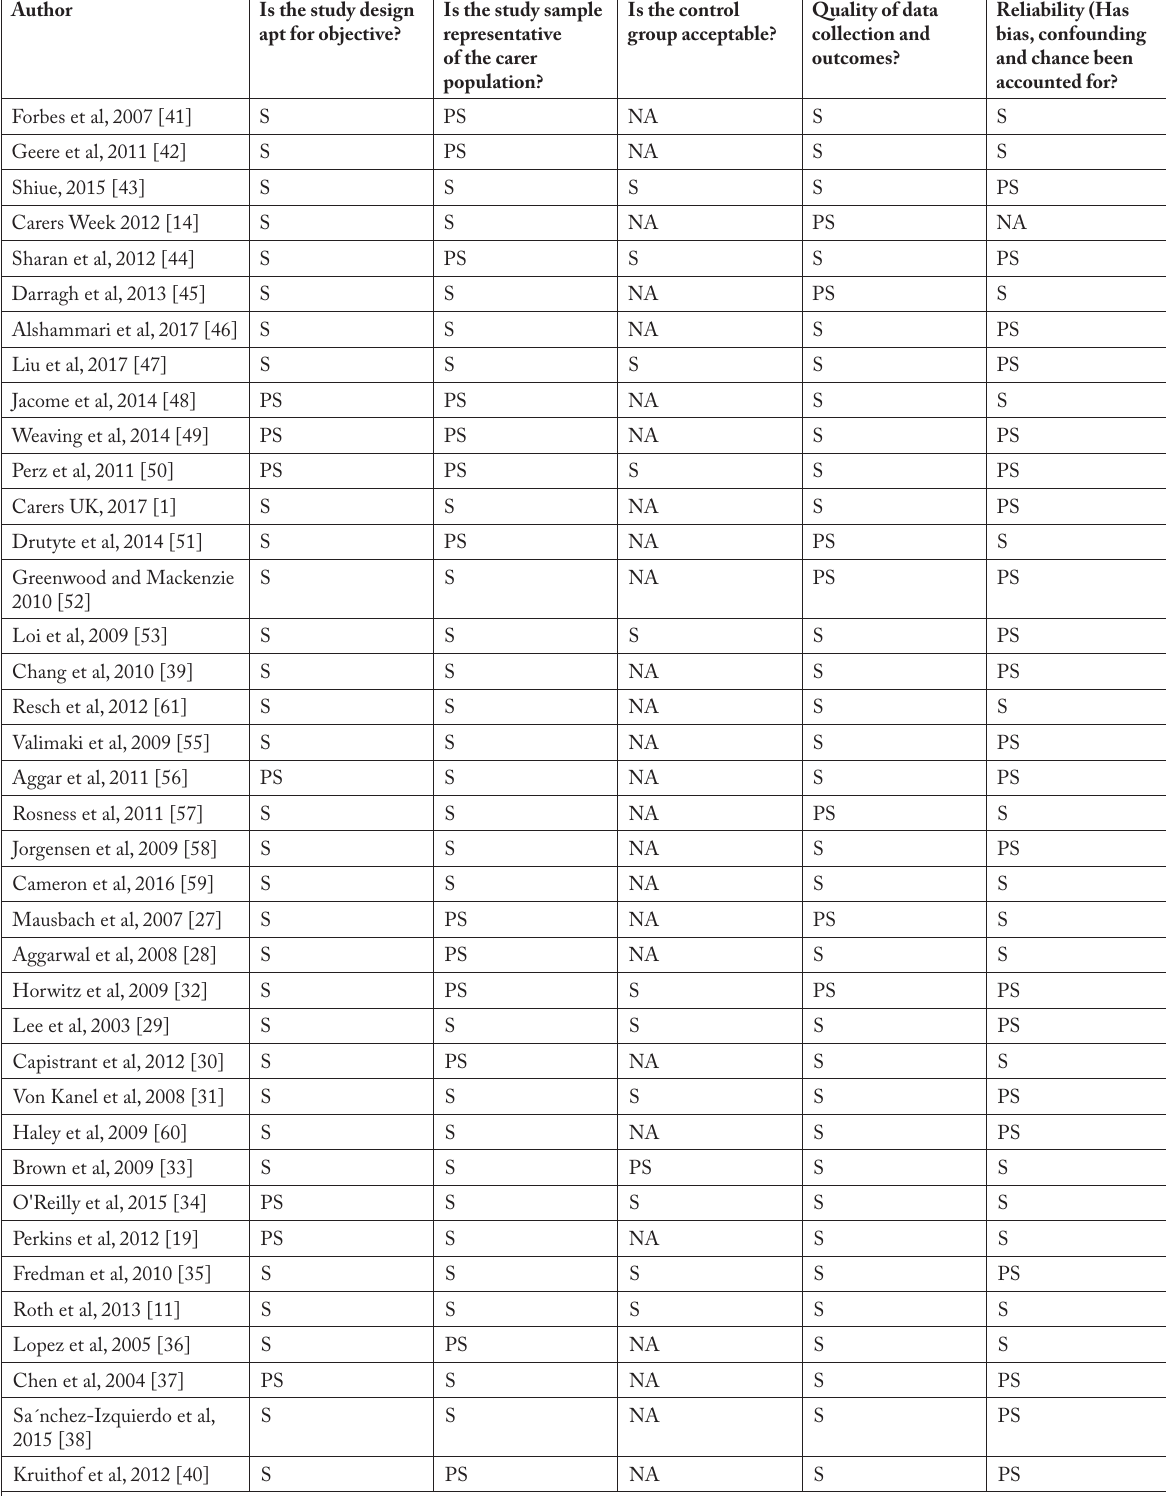
Table 8. Quality evaluation of studies included ( n =